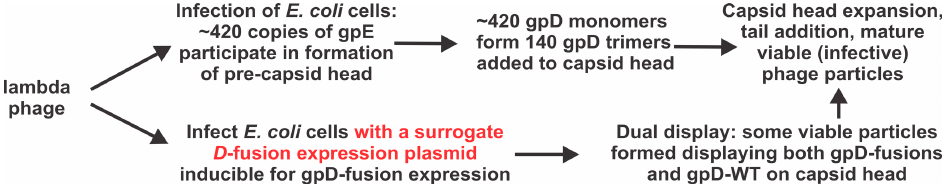
Figure 1. Requirement and participation of gpD wild type (gpD-WT) and / or gpD-fusions in formation of viable lambda phage